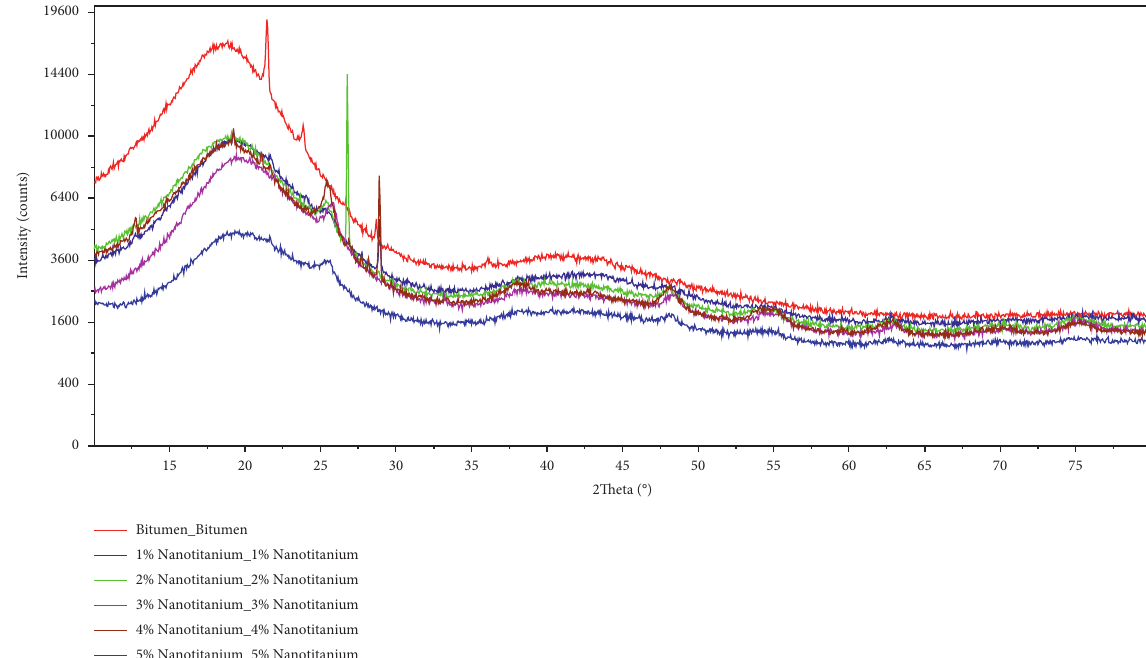
Figure 4: XRD for nano TiO